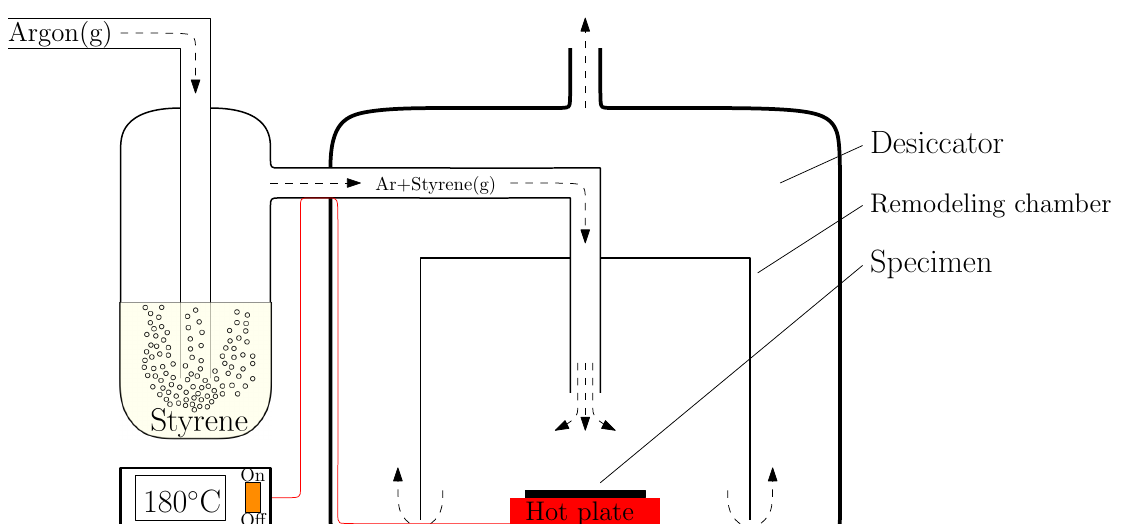
Figure 5. Experimental setup for gold remodeling in an argon/styrene atmosphere. Argon gas flows into a gas washing bottle filled with styrene. From here, a mixture of argon and styrene is guided into a remodeling chamber placed inside a desiccator. Inside the remodeling chamber, the specimen is placed on top of a hot plate. The control box sets the temperature of the hot plate on the outside of the